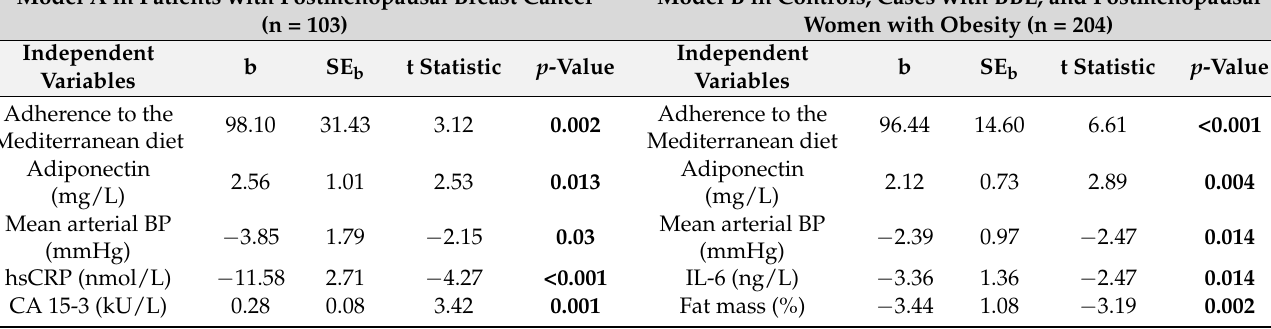
In bold statistically significant results ( p < 0.05). Abbreviations: BP, blood Pressure; hsCRP, high-sensitivity C-reactive protein; IL-6,